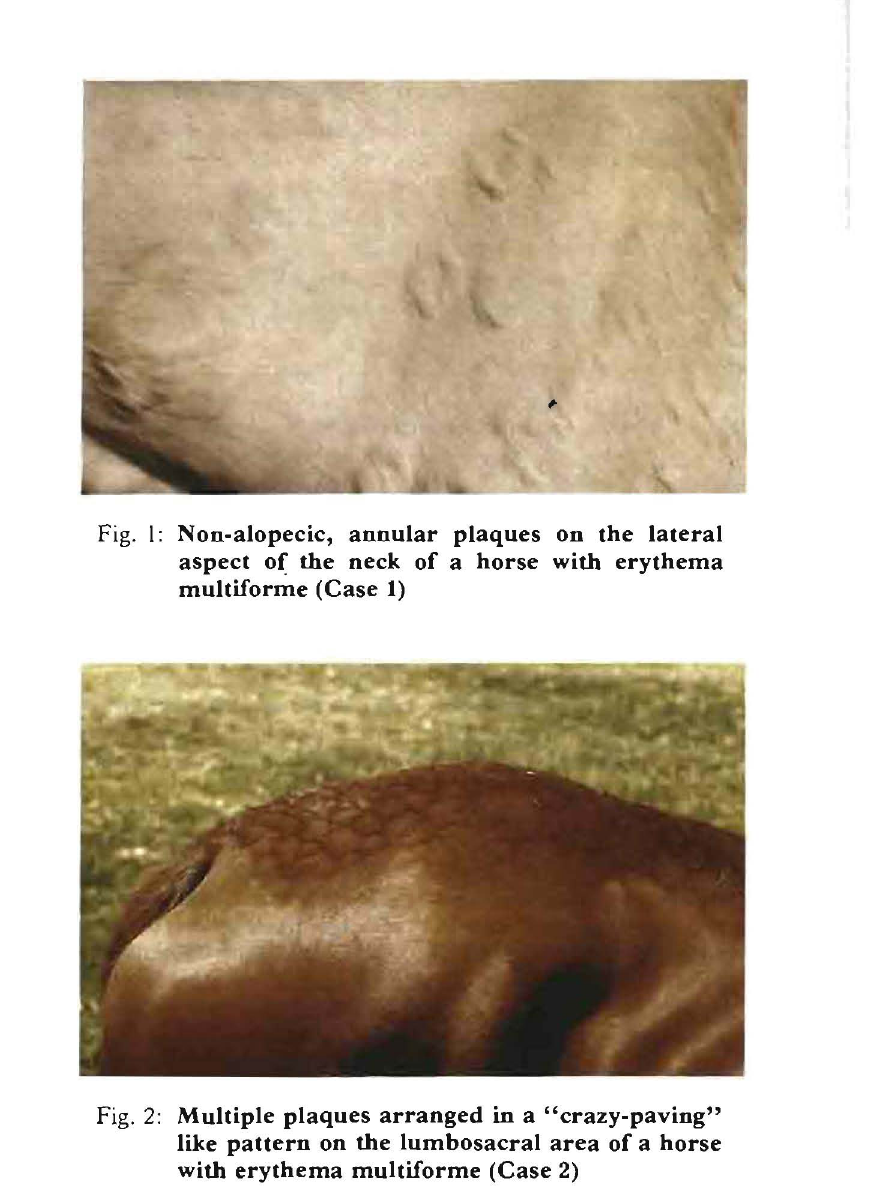
Fig. 2: Multiple plaques arranged in a "crazy-paving" like pattern on the lumbosacral area of a horse with erythema multiforme (Case 2) contact reactants, physical factors. No in itiating factor could be